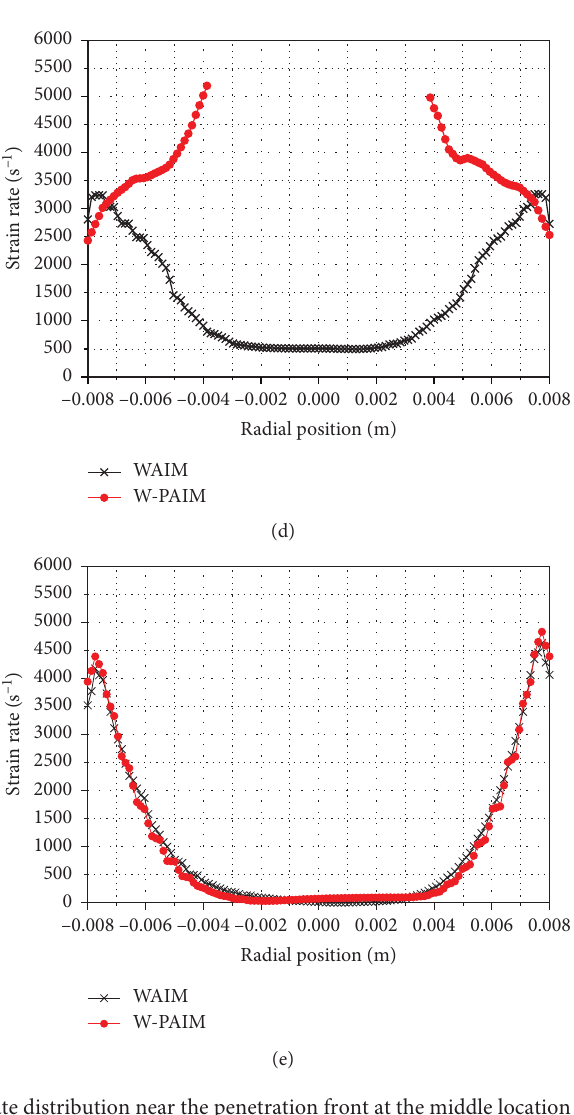
Figure 8: Comparison of the strain rate distribution near the penetration front at the middle location of straight segments between WAIM and W-PAIM: (a) strain rate magnitude contour of WAIM, (b) strain rate magnitude contour of W-PAIM, (c) strain rate profiles at position I, (d) strain rate profiles at position II, and (e) strain rate profiles at position III (I denotes the location of 0.04mm, II is 0.05mm, and III is